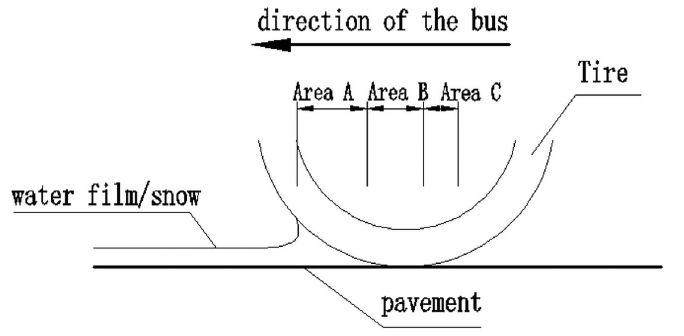
Fig 3. Schematic diagram of tire contact with road